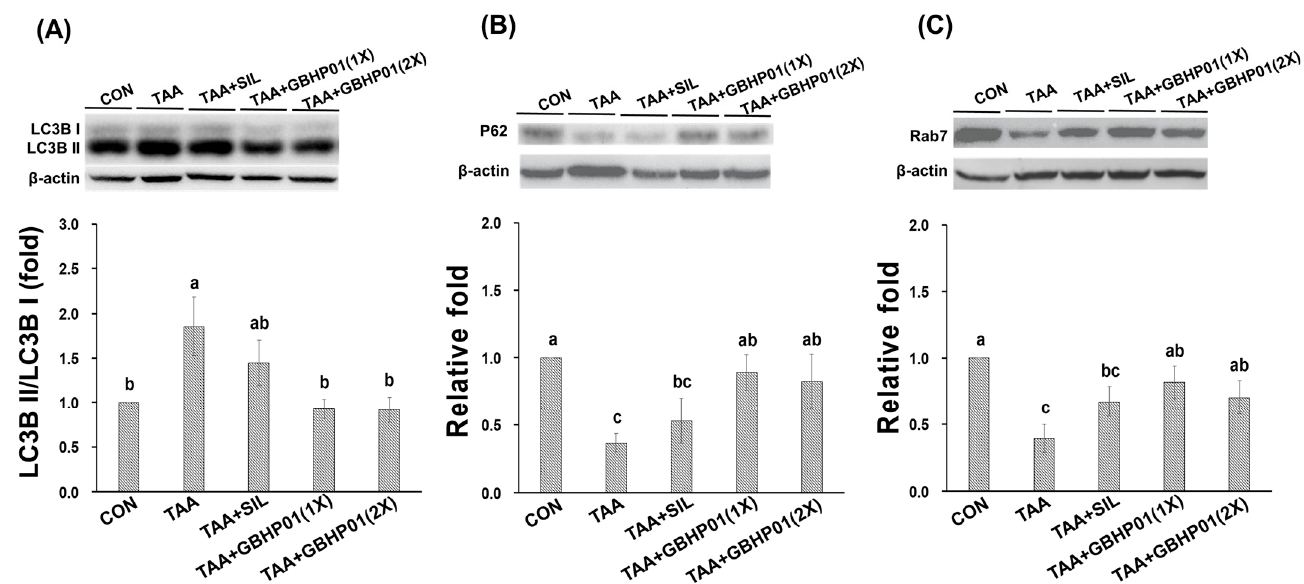
Figure 3. Effects of chicken liver hydrolysate-based supplement (GBHP01 TM ) on autophagy related protein expressions in livers of experimental rats: ( A ) LC3B II/LC3B I, ( B ) P62, and ( C ) Rab7. Data are given as mean ± SEM (n = 8). Data bars in each test parameter without a common letter represent a significant difference ( p < 0.05).